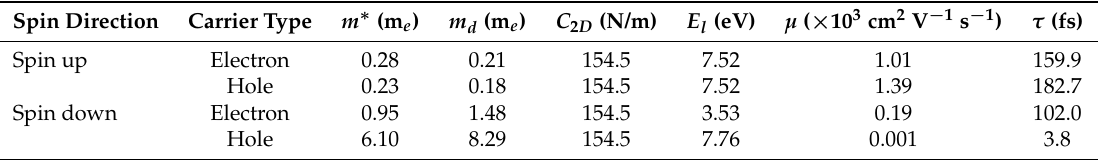
Table 1. The calculated effective mass ( m ∗ ), average effective mass ( m d ), 2D elastic modulus ( C 2 D ), DP constant ( E l ), carrier mobility ( µ ), and relaxation time ( τ ) at the room temperature in both spin channels of NiCl 3